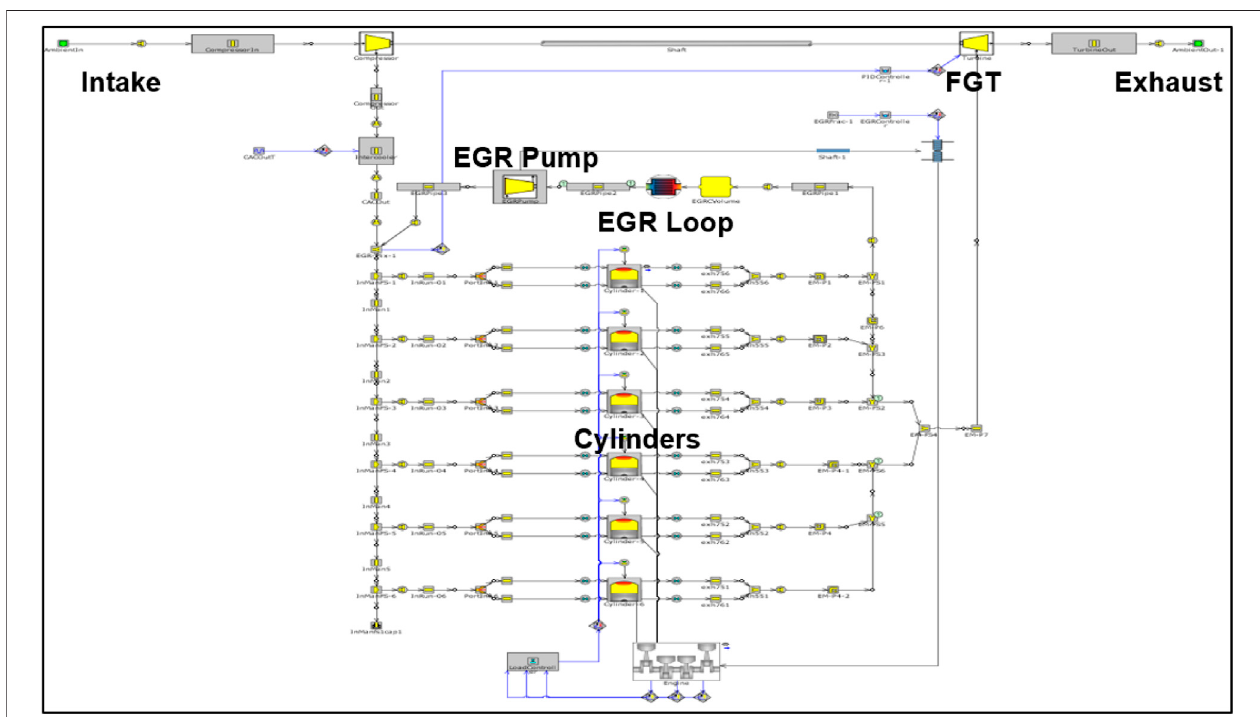
FIGURE 19 | GT-POWER engine model layout with EGR